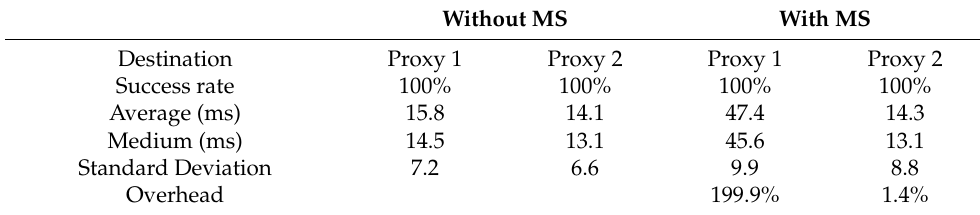
Table 3. Establishing a new connection under a normal